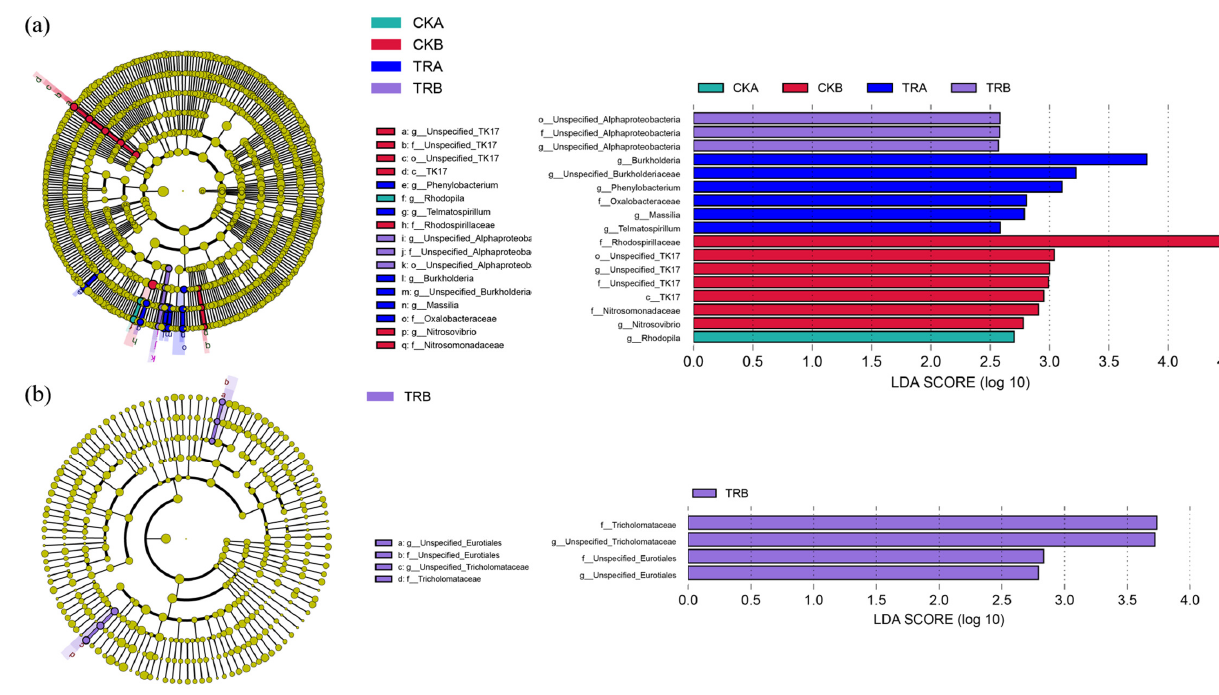
Figure 2. Linear discriminant analysis (LDA) of soil bacterial ( a ) and fungal communities ( b